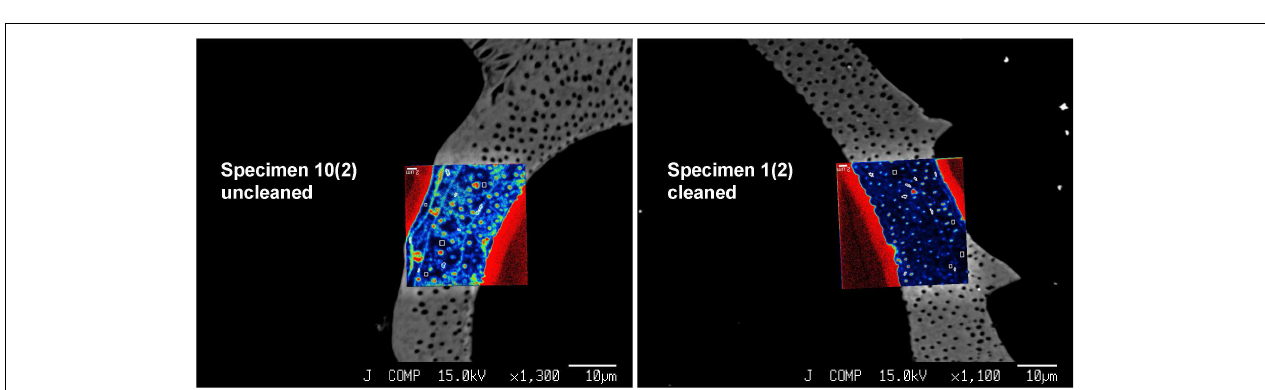
FIGURE 4 | Backscattered electron (BSE) micrographs of two U. striata specimens, overlain by the distribution of the 32 S − / 40 Ca 16 O − ratios. The figure shows a comparison of an uncleaned specimen with a specimen that has been treated by an oxidative cleaning procedure before the embedding for the preparation of the cross-sections. Both NanoSIMS mappings show parts of the epoxy resin from outside the foraminiferal calcite (signal in bright red due to the absence of Ca in the